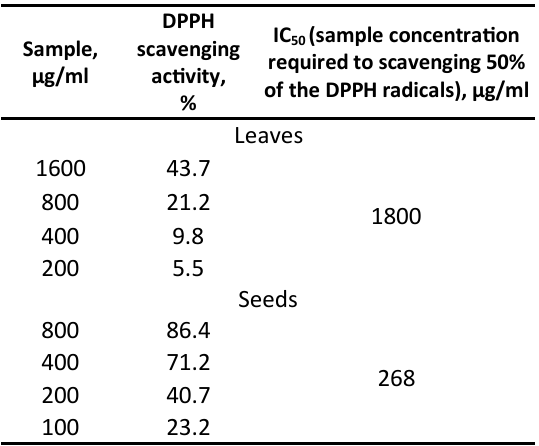
Table 1. The IC of the leaves and seeds 50 of S. marianum